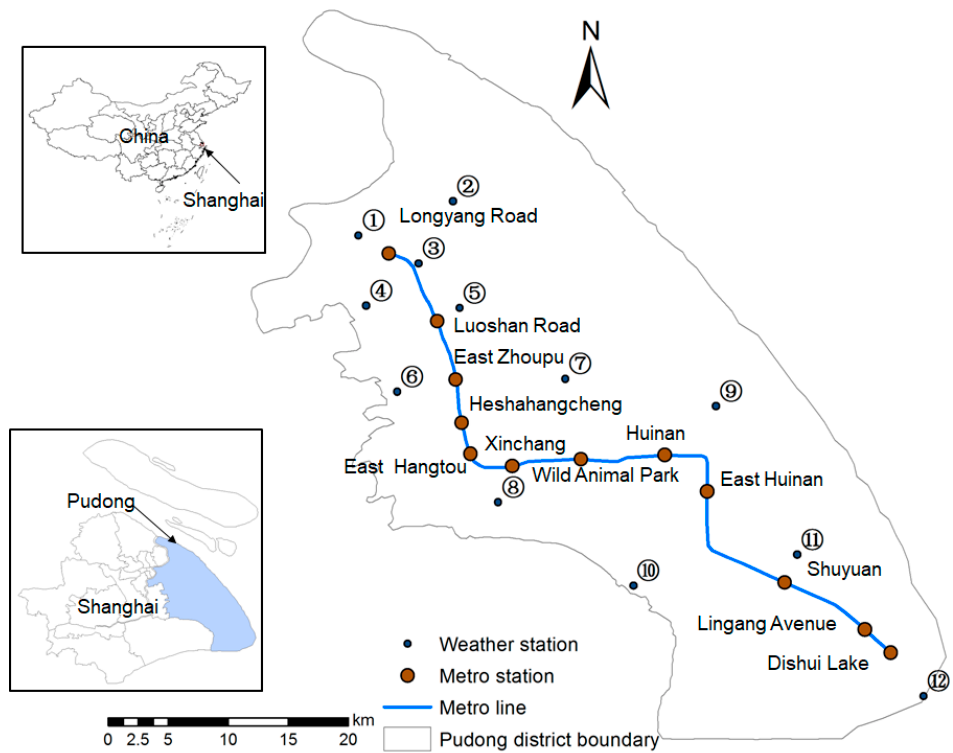
Figure 1. Location of both the Shanghai Metro Line 16 (blue line) with station names (red dots) and 12 AWS (Automatic Weather Stations) around it, within Shanghai (inset), China. Table 1 Typhoons that have affected Shanghai for longer than 3 h between 2005 and 2013. N is the number of hours Shanghai was impacted. A total of 311 h of data were analyzed. TC: Tropical cyclone [25].